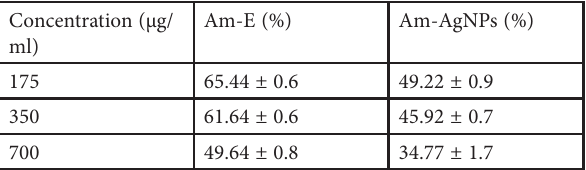
Data were Mean ± SD of triplicate experiments conducted at differ- ent time. Am-E (aqueous leaf extract of A. muricata ); Am-AgNPs